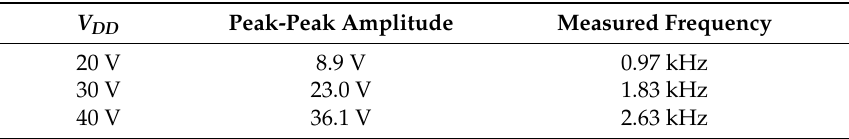
Figure 4. ( a ) Schematic of the three-stage ring oscillator with an output buffer; ( b ) Output voltage of the complementary ring oscillator as a function of time at different V DD .